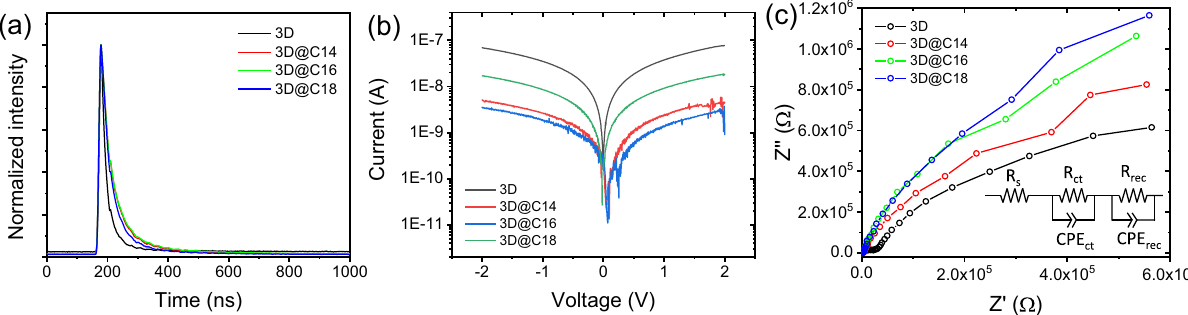
Fig. 3 Solar cell device characterization. a Time-resolved PL decay curves of the 3D-only and 2D perovskite-coated thin fi lms monitored at 766 nm under 450-nm excitation. b Current – voltage curves of 3D-only and 2D perovskite-coated devices measured at room temperature under 1-sun illumination, the IV plots of 3D@C14 and 3D@C16 are smoothened to have a better clarity. c Nyquist plots of 3D-only and 2D perovskite-coated PSC devices measured at a bias of 0.8 V under dark conditions and the inset shows a circuit diagram of an equivalent circuit model that was used for fi tting the Nyquist plots.